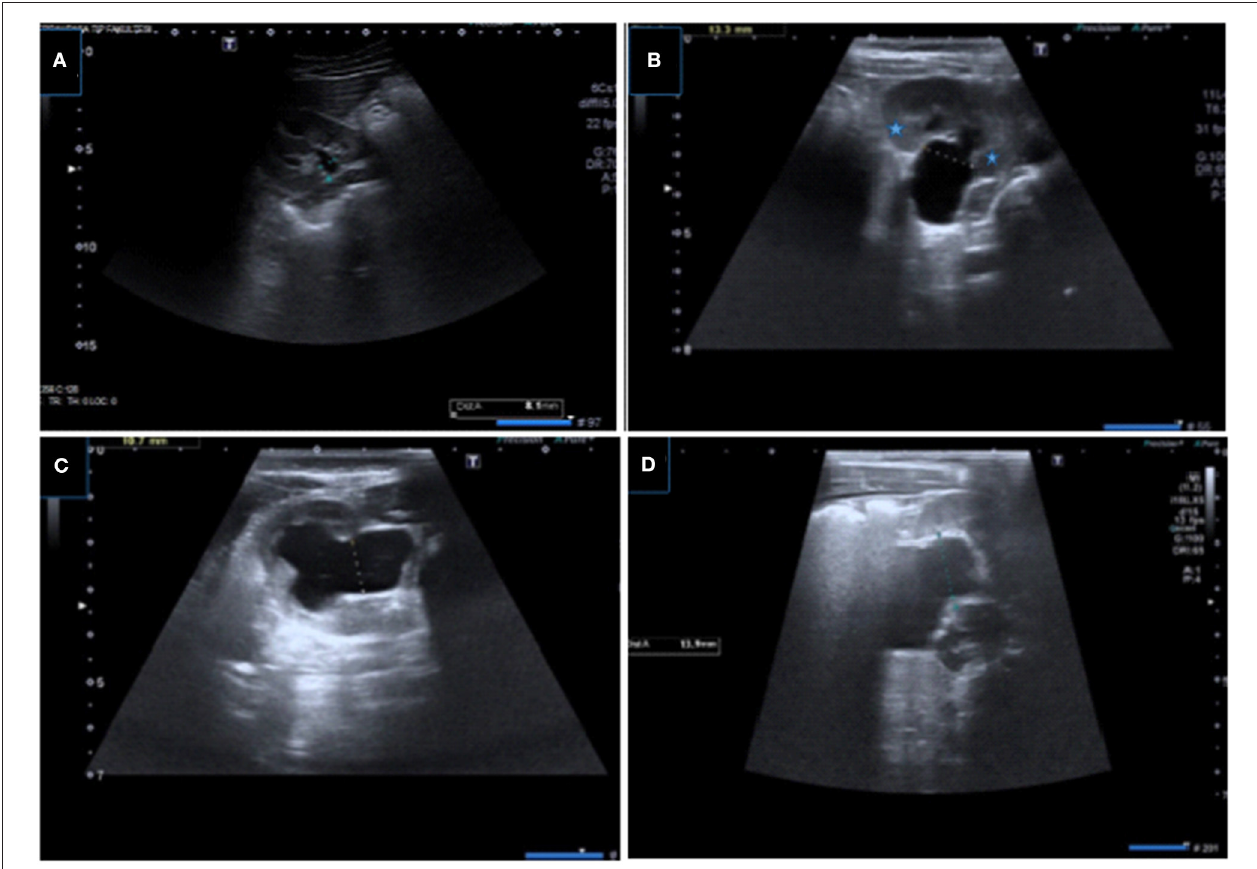
FIGURE 3 | Renal US images showing measurement of APRPD with different grades of hydronephrosis. (A–D) Samples of optimal APRPD measurements obtained within the confines of the renal cortex in transverse